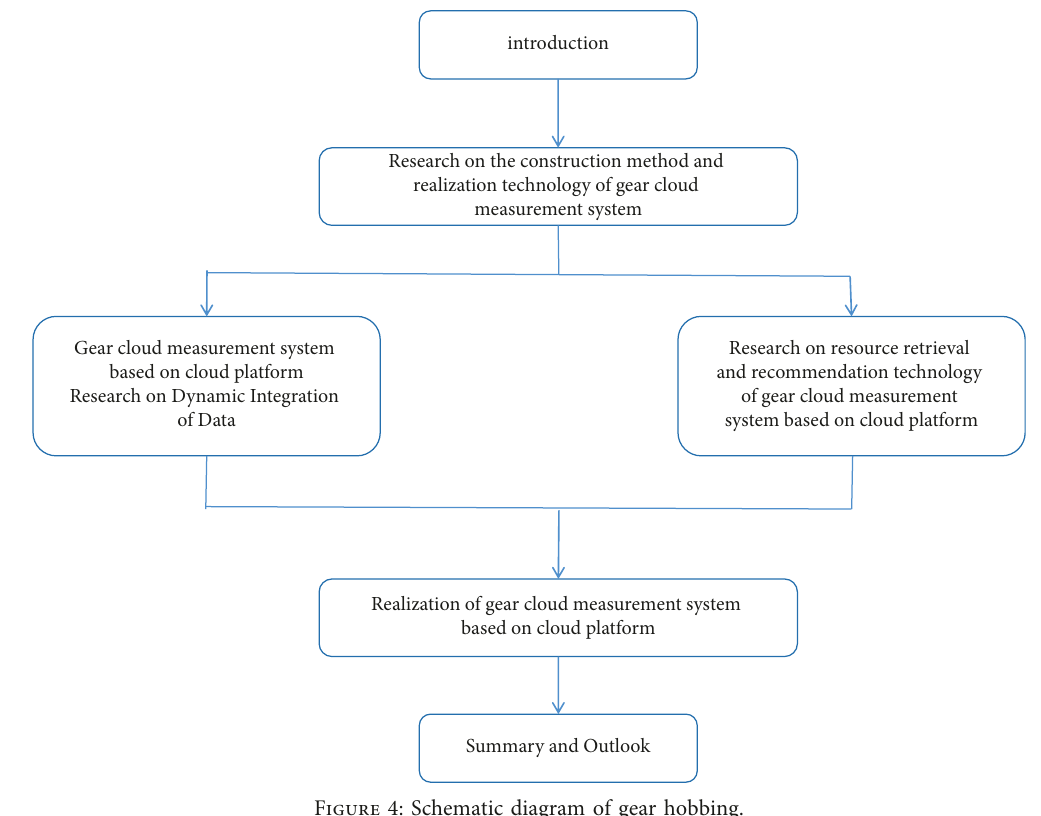
Figure 4: Schematic diagram of gear hobbing.